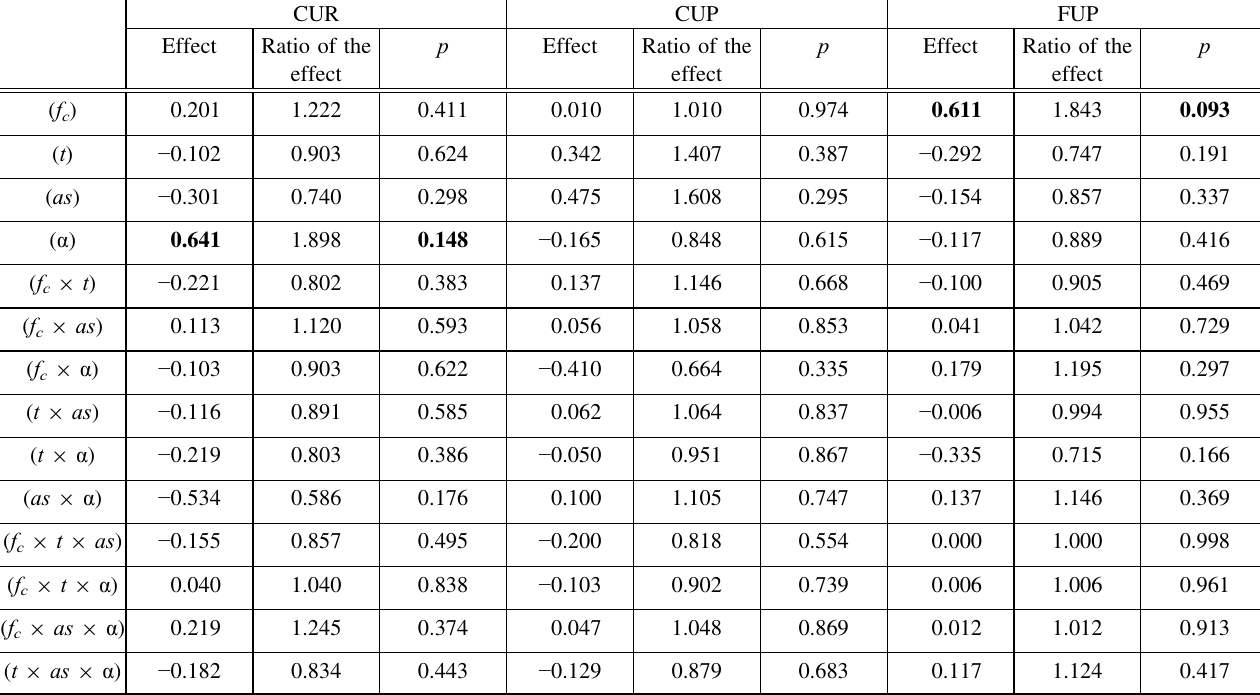
Table 10 Study of the factors and their interactions that affect the variability of the measured Indirect tensile strength values in the group two of experiments a